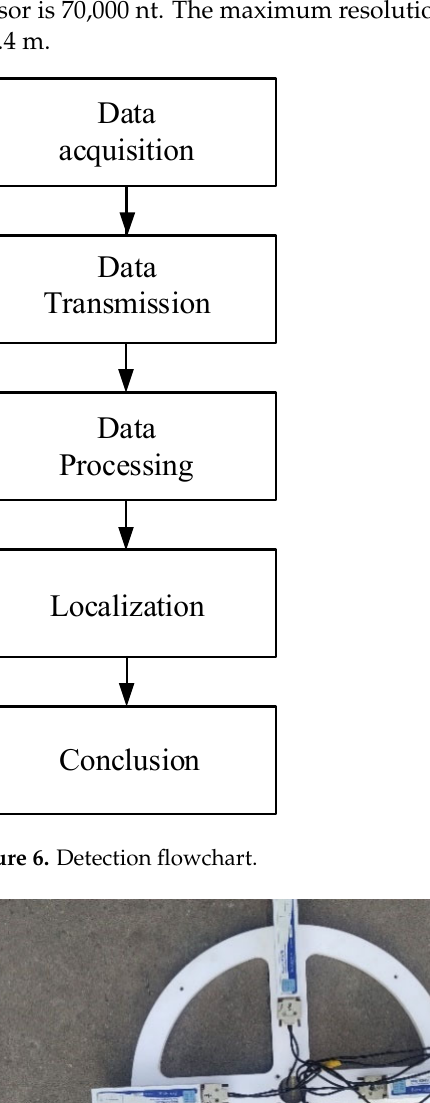
Figure 7. The device consists of four three-axis fluxgate sensors and a nonmagnetic chassis. The operating temperature range of the sensor is − 40~70 ◦ C. The measurement range of the sensor is 70,000 nt. The maximum resolution of the sensor is 0.01 nt. The baseline distance is 0.4 m.